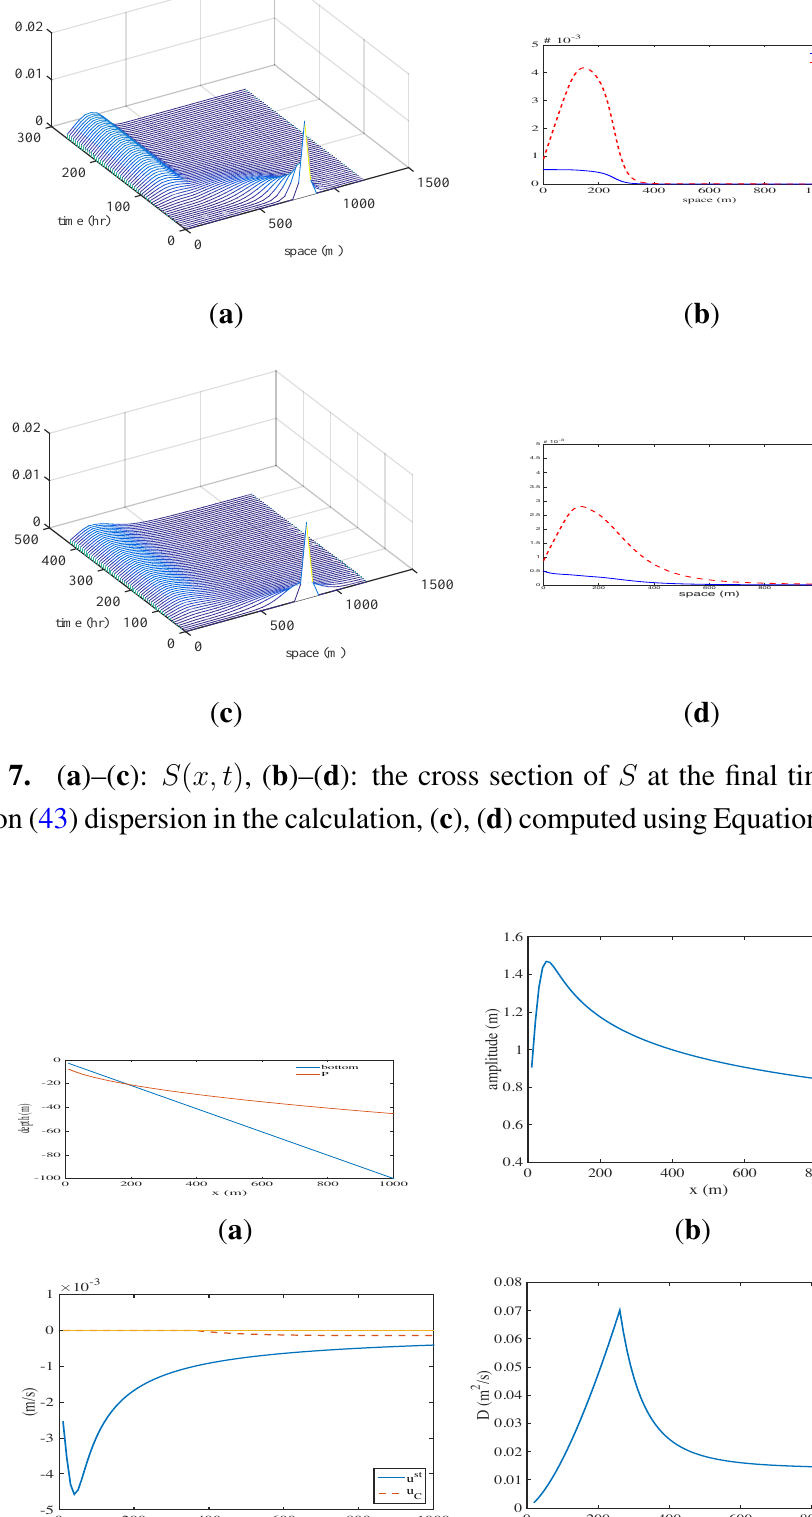
; ( d ) dispersion 0 . 16 K ( x ) C